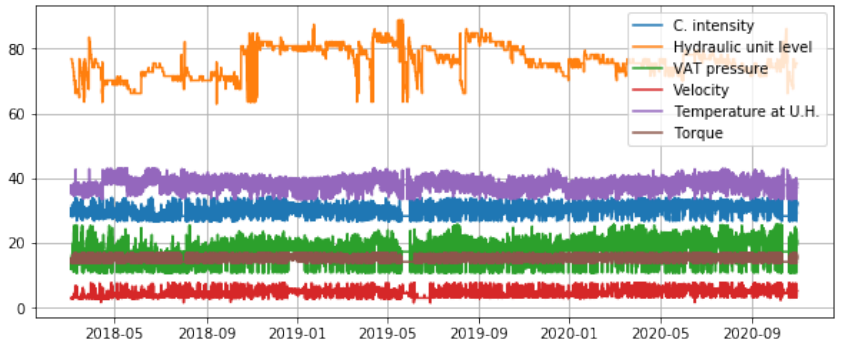
Figure 3. Plot of the dataset values after cleaning discrepant data. The variables are current intensity, hydraulic unit oil level, VAT pressure, velocity, temperature, and torque.